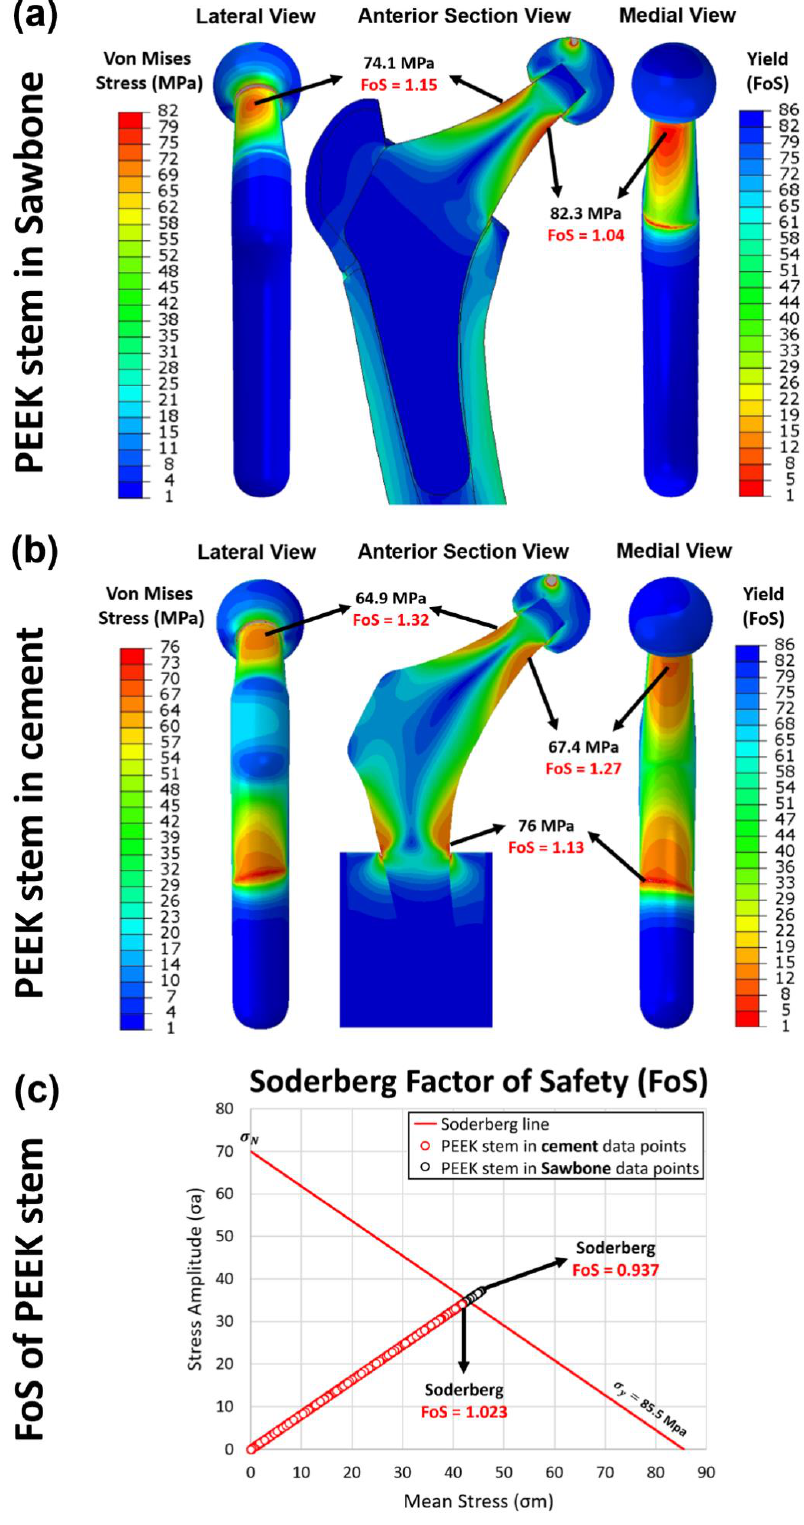
Figure 12. The yield factor of safety distribution in the implanted PEEK stem in ( a ) Sawbone and ( b ) cement, loaded at 2300 N. ( c ) the fatigue factor of safety of each element in the PEEK stem implanted in the Sawbone (black circle) and in the cement (red circle), examined through the Soderberg fatigue theory.